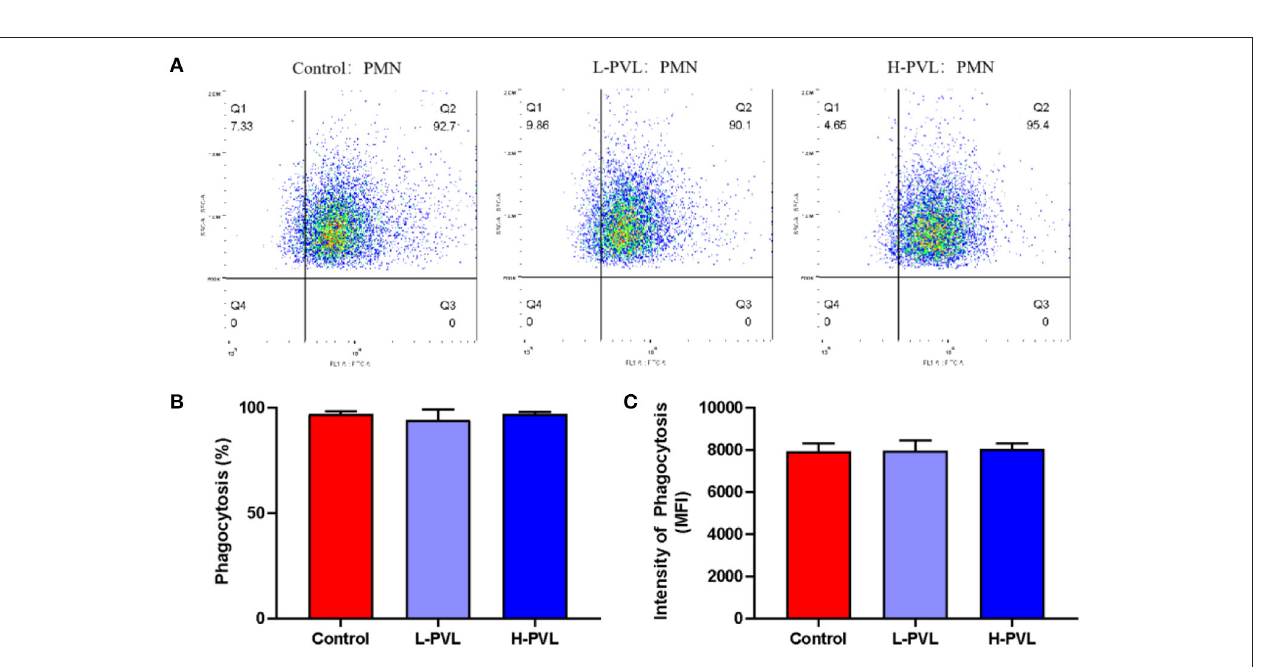
FIGURE 3 | Effect of BLV infection on phagocytosis of PMN. (A) Effect of BLV infection on phagocytosis of PMN, (B) Effect of BLV infection on phagocytic efficiency of PMN, and (C) Effect of BLV infection on phagocytosis of